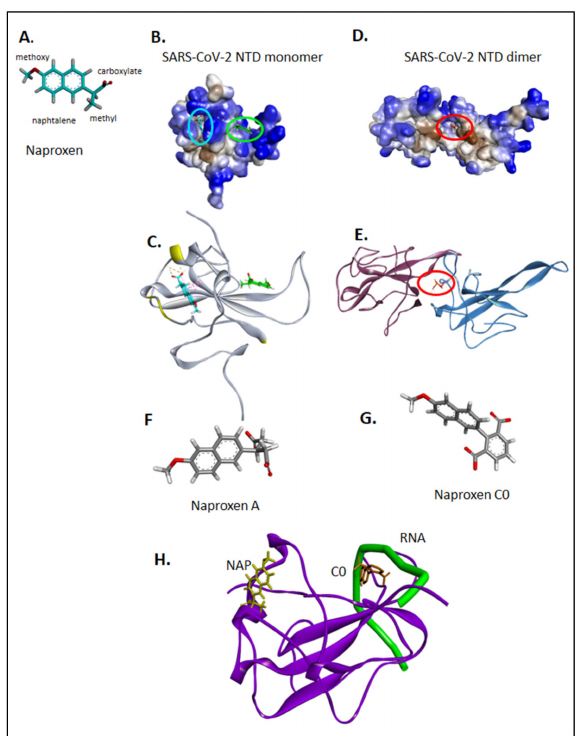
Figure 2. Binding sites of naproxen to N NTD monomer and dimer; comparison with naproxen derivatives. Naproxen is shown in ( A ), with details on its functional moieties as discussed in the text. Panels ( B , C ) show the binding sites of naproxen on monomeric N NTD (PDB 7ACT) [28], the main (more frequent) binding site represented in cyan, is associated with the dimeric interface, highlighted in ( C ) in yellow; the minor site of naproxen on monomeric N NTD is represented in green. In panels ( D , E ) is shown the main binding site of naproxen on dimeric N NTD (PDB 6VYO) [27]. For details, see also Supplementary Figure S2. The structures of naproxen A and C0 are shown in panels ( F ) and ( G ), respectively. Panel ( H ) summarizes the RNA binding site (shown in green) deduced from RMN studies [28], the main binding site of naproxen on the left and the main binding site of naproxen